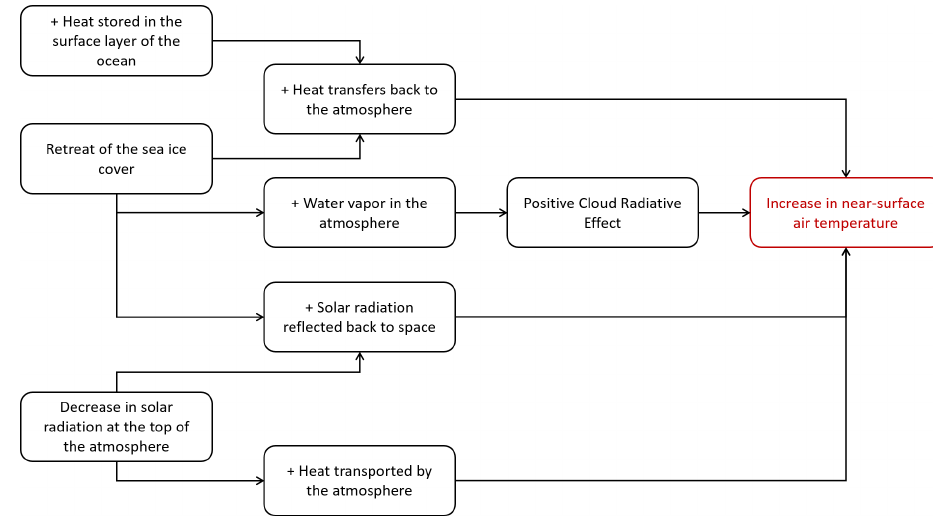
Figure 16. Diagram of the Last Interglacial climate processes and feedback involved in the Arctic autumn